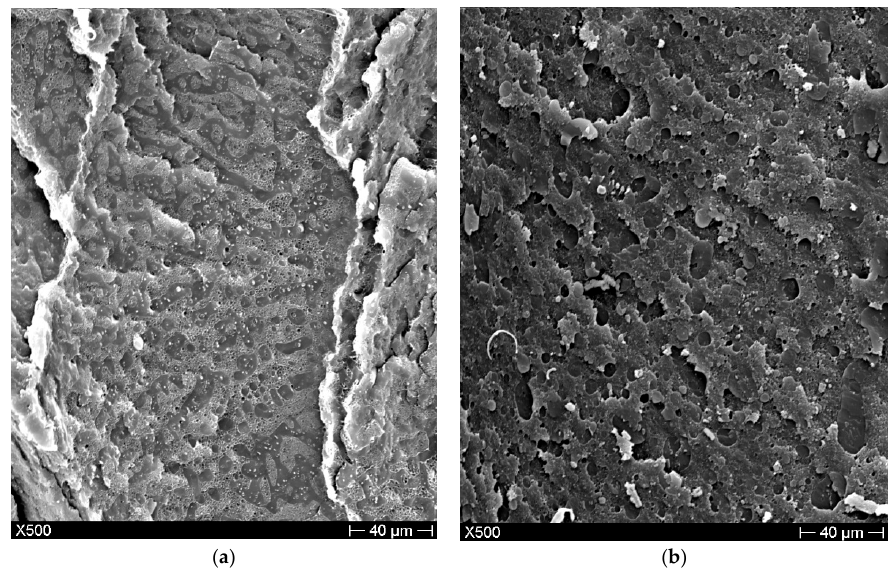
Figure 4. Blend morphology of the cryo-fractured surface of ( a ) HDPE50/PLA50-Lot3, ( b ) HDPE50/PLA50-Poly3.